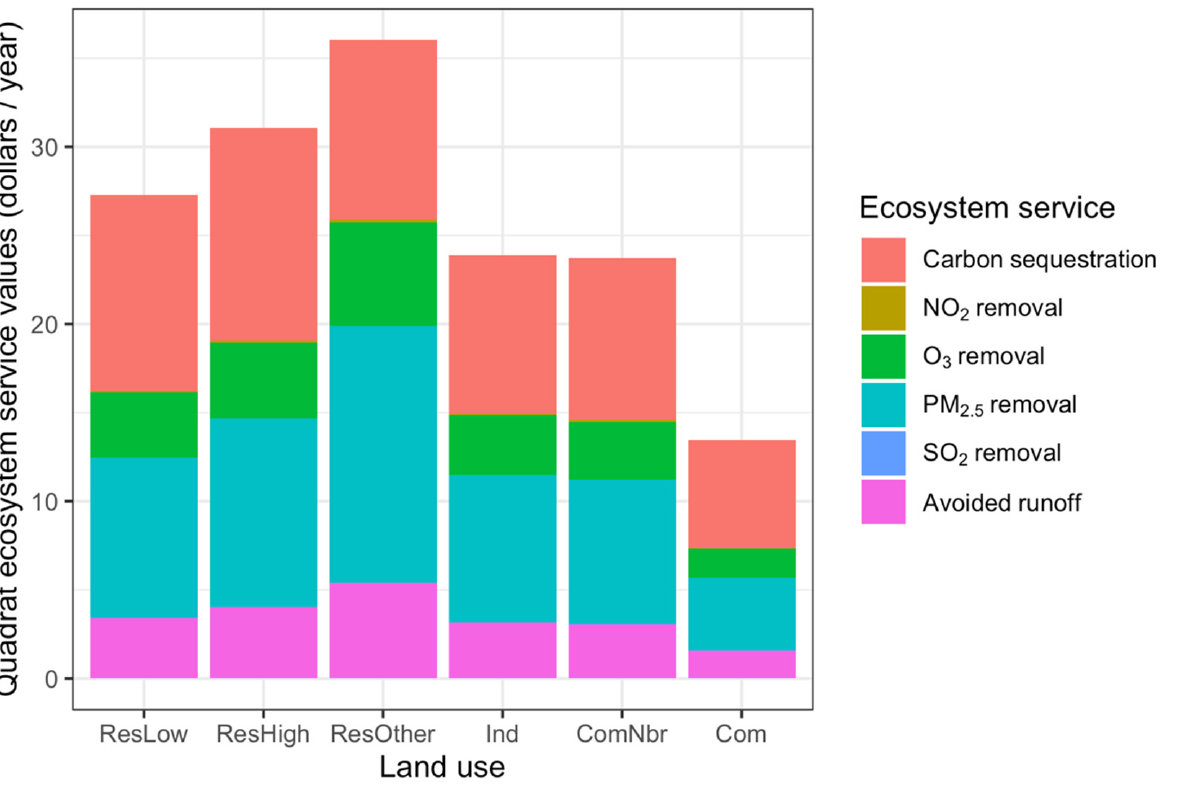
Figure 4. Average valuation of quadrat annual ecosystem services across land use classes.